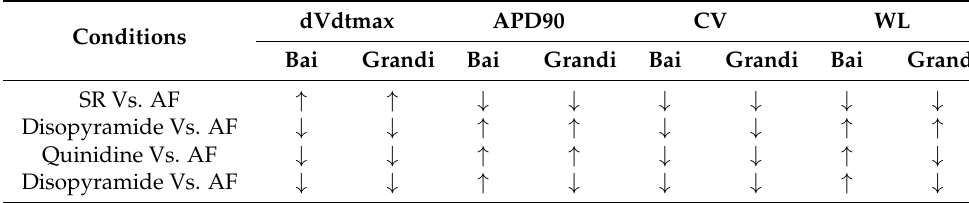
Table 8. Alterations of electrophysiological